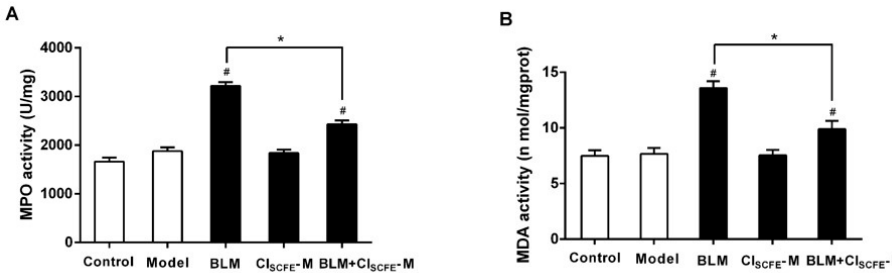
Figure 7. Effect of CI SCFE on BLM-induced oxidative stress. ( A ) Myeloperoxidase (MPO) activity; ( B ) malondialdehyde (MDA) activity. Data are represented as mean ± SEM ( n = 8). # p < 0.05 vs. model group; * p < 0.05 vs. BLM group.